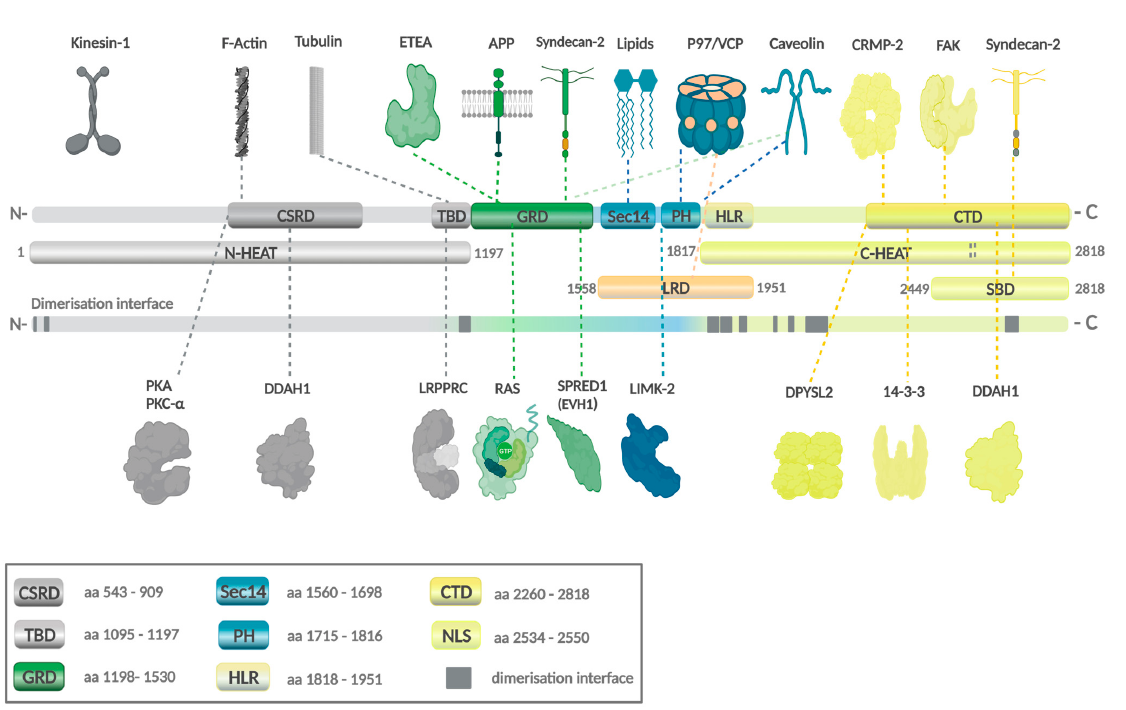
Figure 3. Domain architecture of neurofibromin: The lemniscate NF1 complex is formed by a head-to-tail dimer of an N-terminal HEAT domain (N-HEAT) and a C-terminal HEAT domain (C-HEAT) [58]. The GRD domain possesses a Ras-GAP function. The cysteine and serine-rich domain/Ras- GTPase activating protein domain (CSRD) and the C-terminal domain (CTD) harbour phosphory- lation sites, and they are anticipated to regulate GAP-activity when phosphorylated by protein ki- nase C (PKC) and cAMP-dependent protein kinase A (PKA) [59]. Phosphorylation at the CSRD do- main potentiates the Ras-GAP activity [60], while phosphorylation at multiple serine residues in the CTD prolongs activation of the Ras/extracellular signal-regulated kinase (ERK) pathway [61], me- diates nuclear import of neurofibromin during the cell cycle [62], and facilitates neurofibromin in- teraction with 14-3-3 that negatively regulates the GAP-activity [63]. CTD includes a nuclear locali- sation signal (NLS). Aside from binding to Ras, the GRD also interacts with tubulin via its tubulin- binding domain (TBD) motive [64]. Bipartite module Sec14-homologous segment and pleckstrin ho- mology (PH)-like domain binds phospholipids and is structurally well characterised [65]. Caveolin (CAV1) binding sites are spread over the GRD and the Sec14/PH-domain [66]. CAV1 interacts with Musashi-2 (MSI2), and knockdown of MSI2 elevates the CAV1 protein expression, inhibiting the ubiquitinylation of CAV1 [67]. The leucine-rich domain (LRD) consists of 393 amino acids and in- cludes SEC-PH and Heat-like repeat (HLR) domains. It is involved in membrane localisation through the binding with lipids, actin remodelling through the Rho–ROCK pathway, and dendritic spine formation through VCP. As a neurofibromin creates a high-affinity dimer, on the bottom with the gray colour are shown primary dimerisation interfaces [58]. The figure was created with Bio- Render.com (XR2390NUCR, 27.11.2021) and adapted from [68,69]. Upstream of neurofibromin, mainly transmembrane receptor tyrosine kinases (RTKs) regulate extracellular ligand binding and transduce signals into the cells. They regulate signalling cascades such as the RAS/ERK pathway and therefore interfere with neurofibromin. Therapies using RTK inhibitors may fail when NF1 mutations abrogate the effect on the cascade. Interestingly, Anaplastic Lymphoma Kinase (Alk ) was shown to co- localise and interact with neurofibromin in Drosophila and was demonstrated to activate